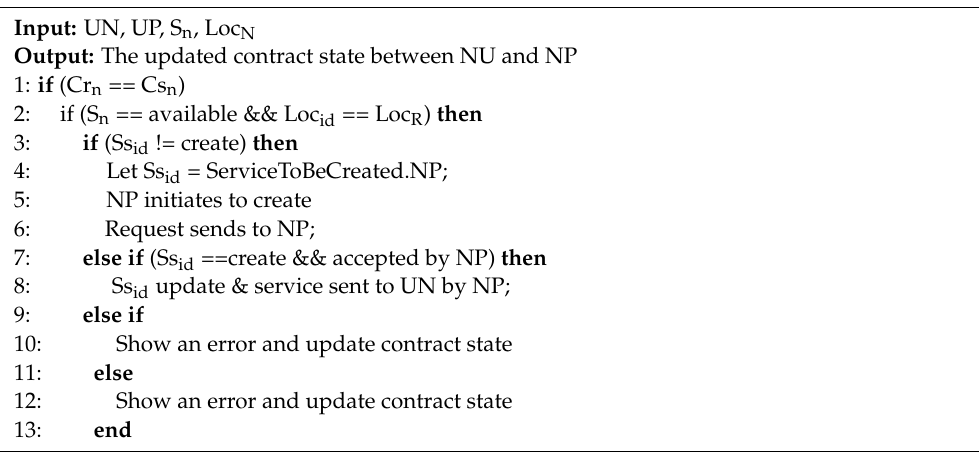
Algorithm 1. Smart contract between UN and carrier NP